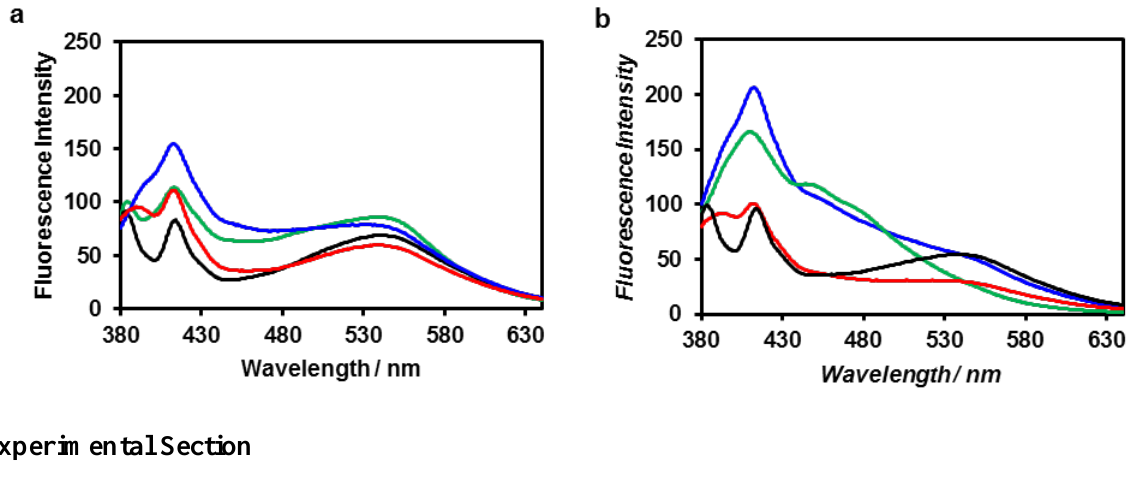
Figure 7. Fluorescence spectra of (black) ZnO nanoparticles, (blue) a mixture of ZnO nanoparticles and peptide 1 , (red) a mixture of ZnO nanoparticles and peptide 2 and (green) a mixture of ZnO nanoparticles and peptide 3 at [ZnO] = 0.1 mM and [peptide] = 0.1 mM in 10 mM Tris-HCl buffer (pH 7.4) at 25 °C; ( a ) immediately after preparation and ( b ) after 24 h. Excitation wavelength: 340